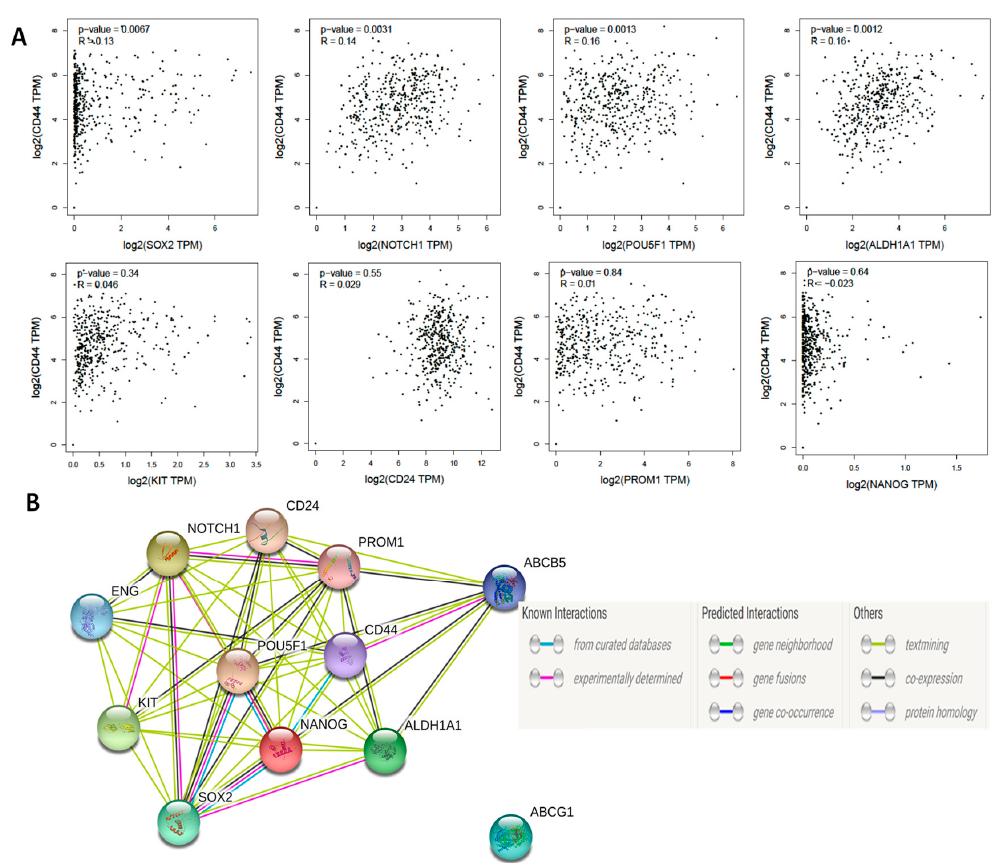
Figure 1. ( A ) Pearson’s correlation of CD44 with other ovarian cancer (OvCa) stem cell (OCSC) markers. ( B ) Predicted protein-protein interactions of OCSC markers using STRING web tool.